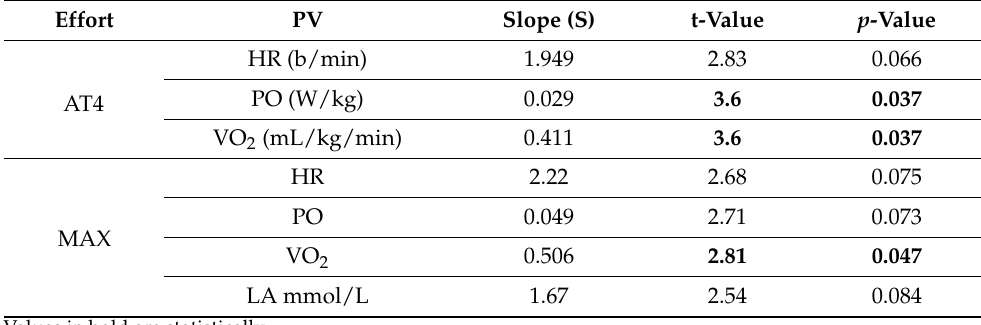
Table 6. Trends’ regressions expressed as the formula PV = S × day of preparation.